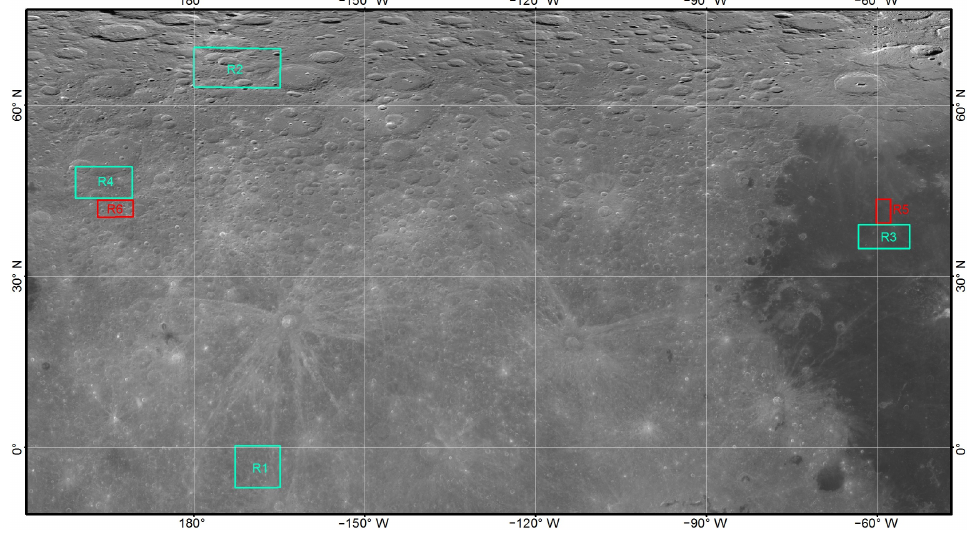
Figure 1. Distribution of the Research